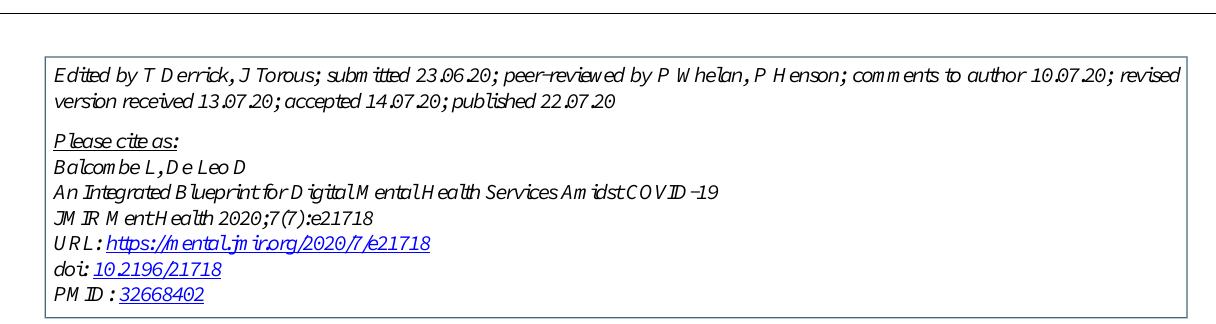
COVID-19: coronavirus disease NASSS: nonadoption, abandonment, scale-up, spread, and sustainability PTSD: posttraumatic stress